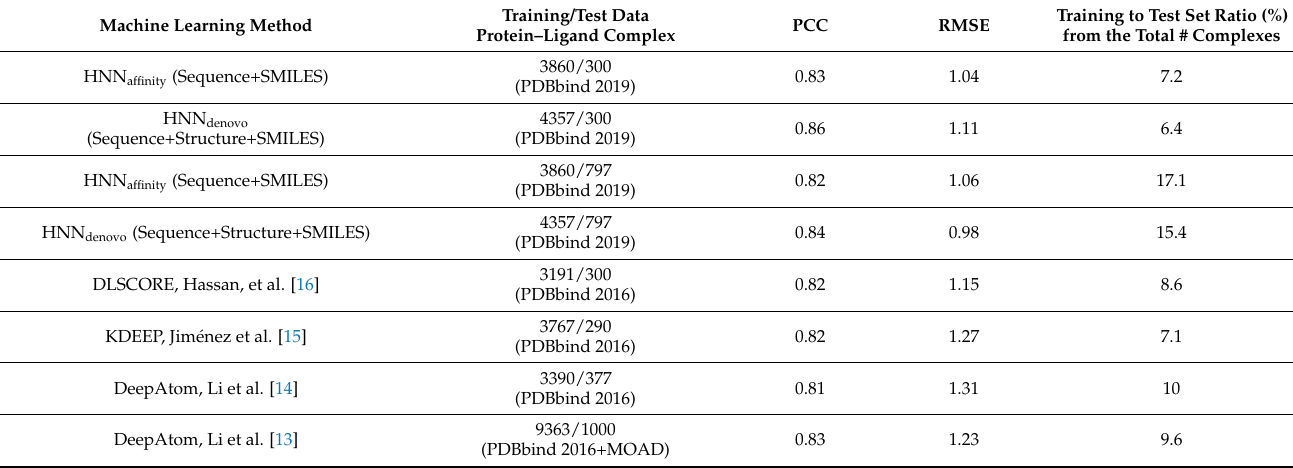
Table 2. The predictive performance (PCC and RMSE) comparison of the HNN-affinity, HNN-denovo, and the literature reported deep learning methods for the PDBbind 2019 refined